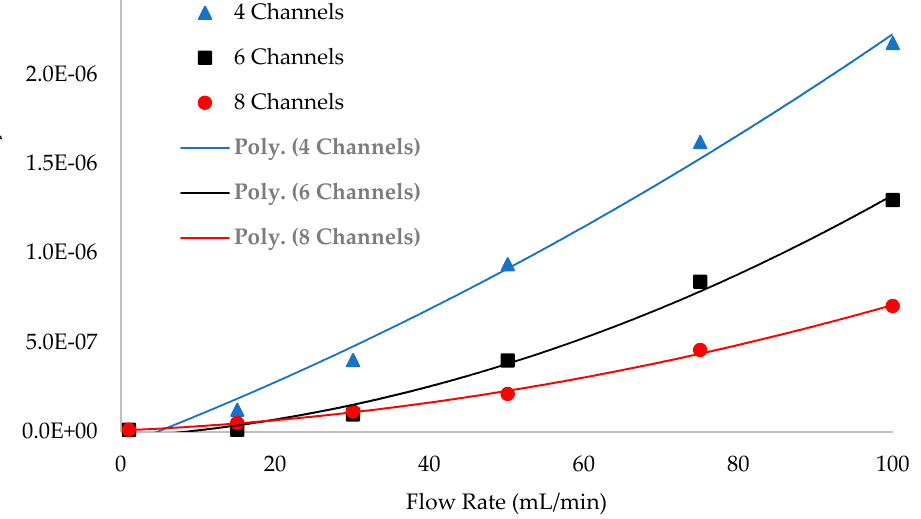
Figure 19. Influence of the number of channels of the heat sink on the FDU coefficient.